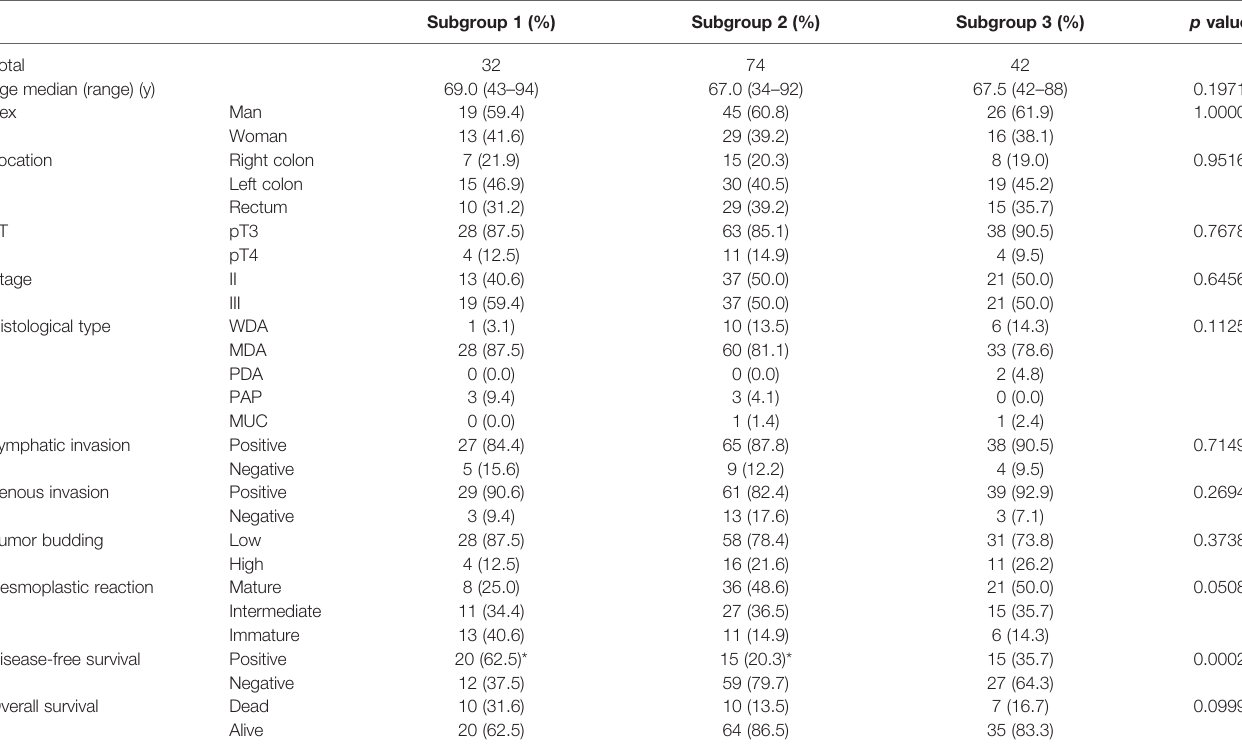
TABLE 2 | Clinicopathological variables according to each subgroup in the fi rst